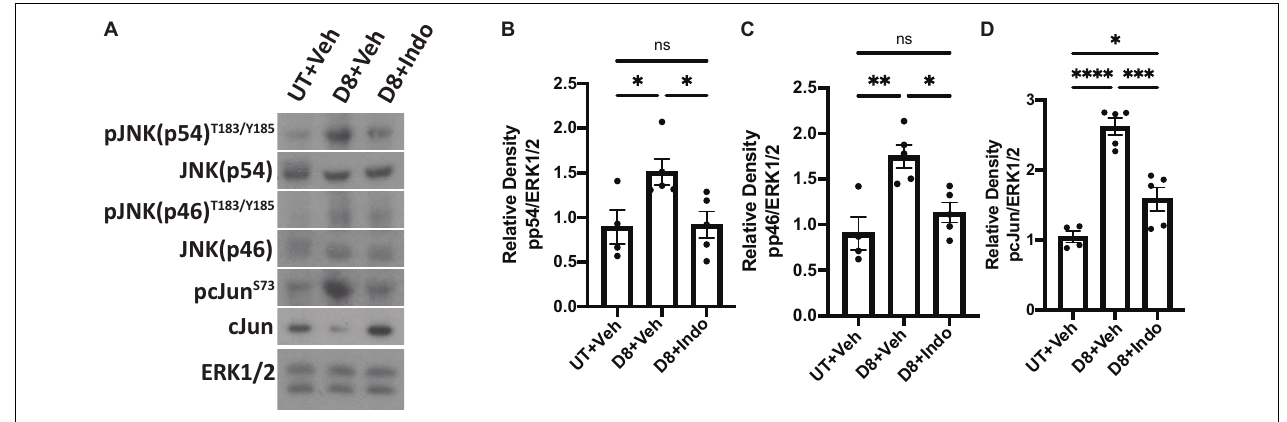
FIGURE 6 | Indomethacin reduces JNK signaling in vivo at day 8 post-IR. (A–D) C57BL/6J mice were untreated (UT) or received 5 Gy radiation with intraperitoneal injections of vehicle (Veh, saline with 10% ethanol) or indomethacin (Indo, 1 mg/kg body weight) at days 3, 5, and 7 post-IR. Parotid glands were collected at day 8 post-IR. (A) Representative Western blot images of phosphorylated JNK signaling molecules following radiation and indomethacin treatments. (B–D) Densitometry of Western blots represented in panel (A) . (A–D) Immunoblots were generated from tissue lysates using antibodies against phospho-JNK/SAPK (p54/p46) T183 / Y185 , or phospho-c-Jun S73 , which were stripped and re-probed for JNK/SAPK (p54/p46) or c-Jun and then ERK1/2 as a loading control. Densitometry was performed using ImageJ software and protein content was normalized to the average of UT + Veh-treated mice. Graphs represent the mean ± SEM. Each closed circle represents an independent sample. Significant differences were determined via a one-way ANOVA followed by Bonferroni’s post hoc comparisons (* p < 0.05, ** p < 0.01, *** p < 0.001, **** p < 0.0001, ns = not